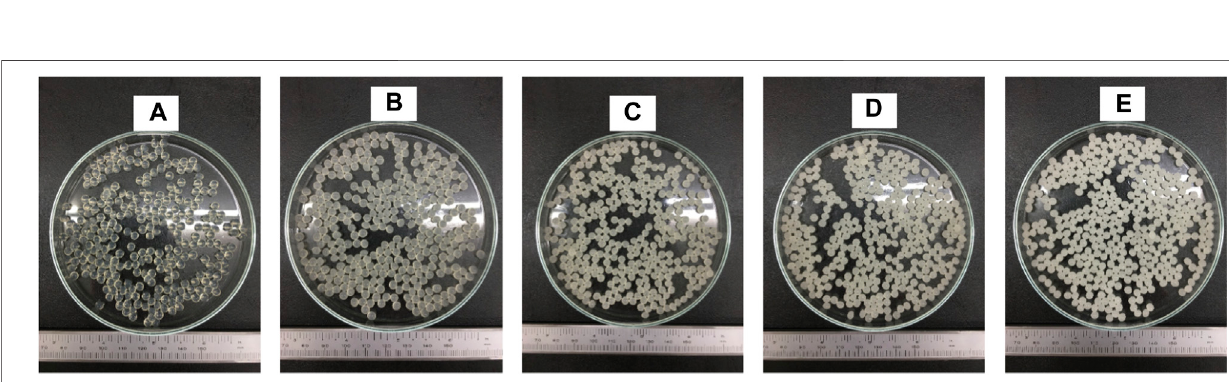
Frontiers in Bioengineering and Biotechnology |